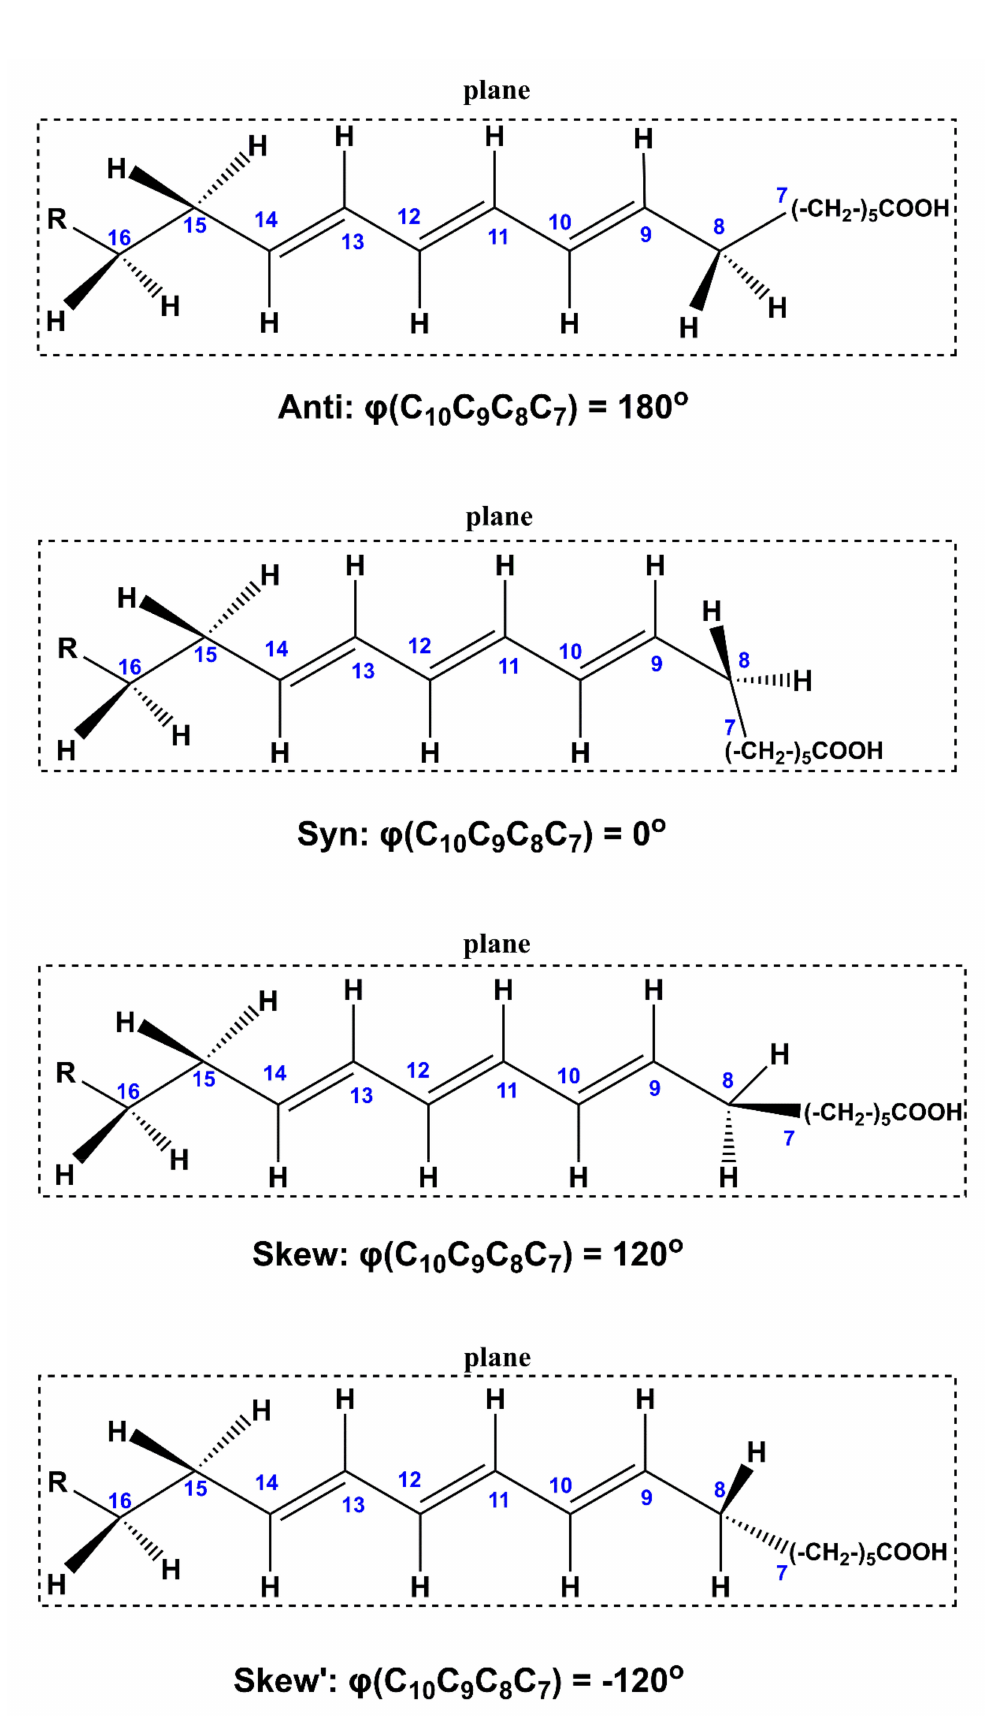
Figure 8. Definition of various conformations of the allylic carbon C8 of β -eleostearic acid (9 E ,11 E ,13 E